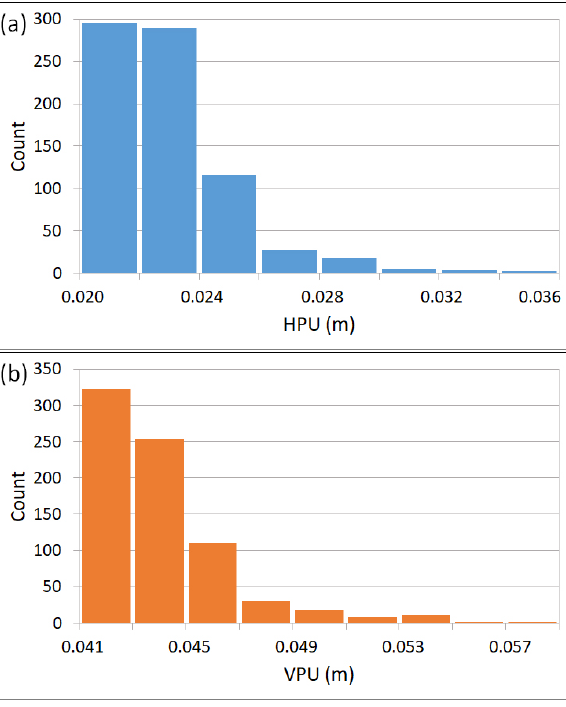
Fig. 3. Calculated (a) HPU and (b) VPU for NRTK observations based on CQ output.